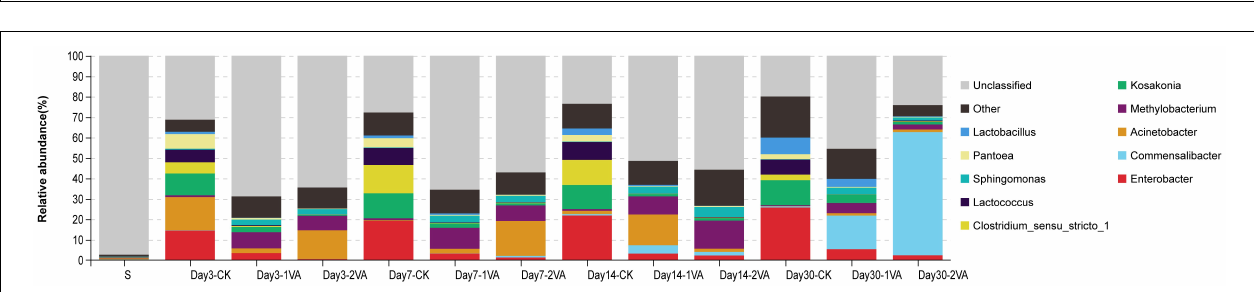
FIGURE 3 | Relative abundance of bacterial community on phylum level in stylo silage ensiled with the addition of vanillic acid (S: raw material, i.e., fresh stylo, CK: blank control, 1 and 2%: addition of 1 or 2% vanillic acid).